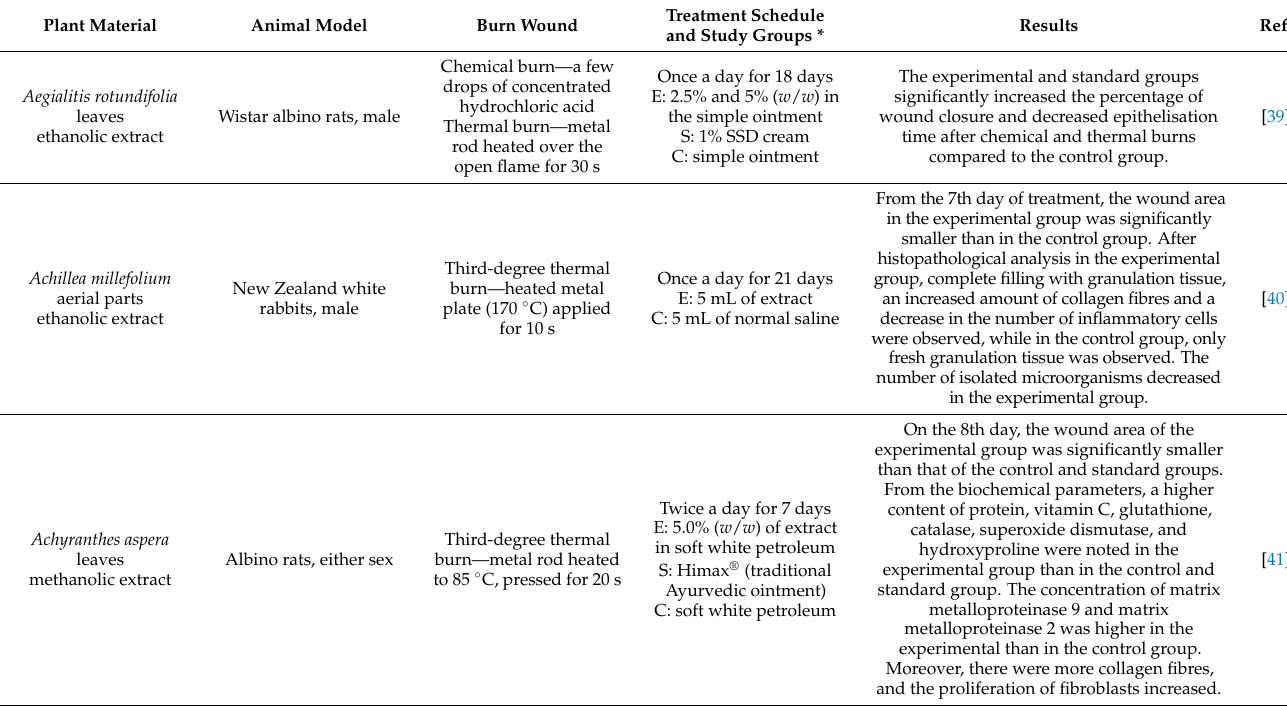
Table 1. In vivo studies on animal models—single